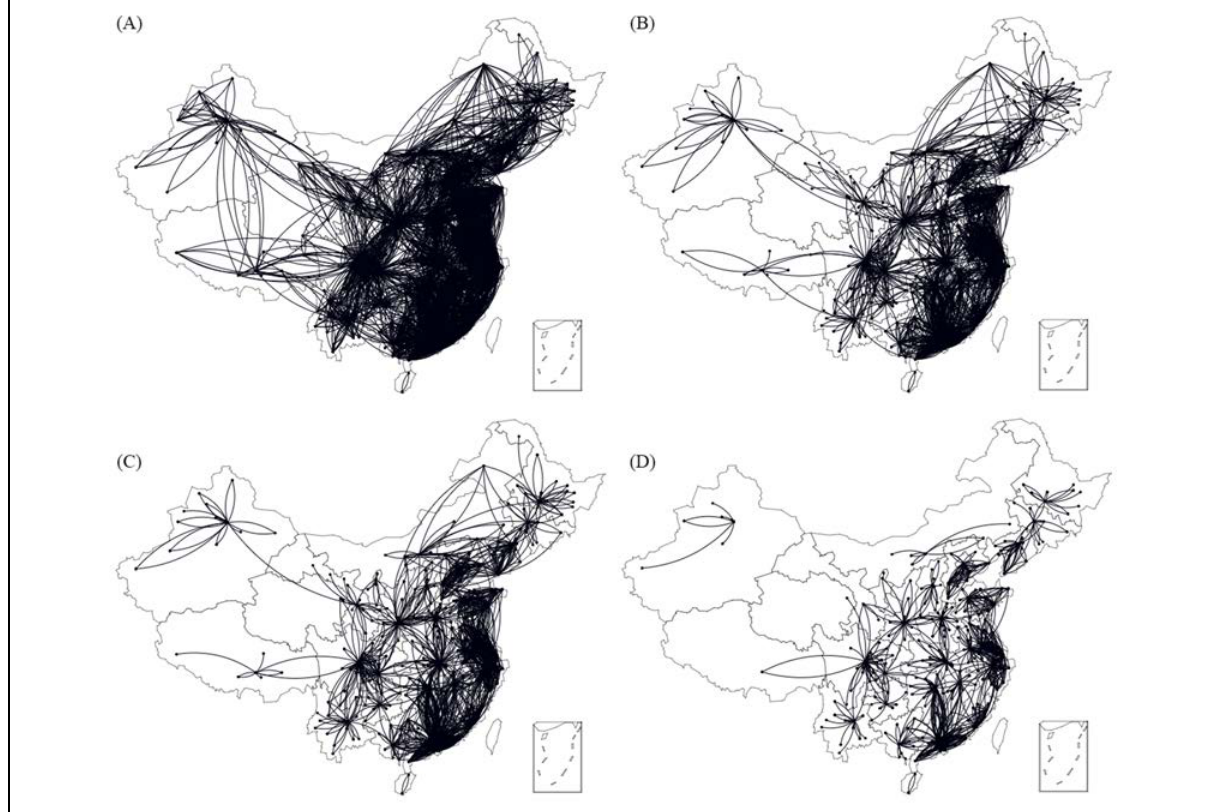
Figure 1 Distribution and strcture of migration flows (from A to D: l >1, l >3, l >5, l >16). The flows follow a clockwise